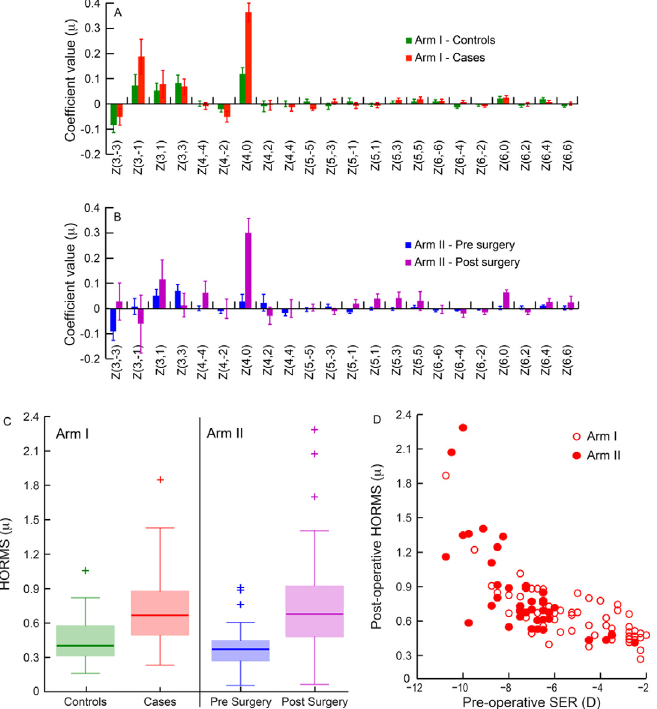
Fig 1. Panels A and B: Histograms showing the pattern of HOA ’ s observed in the first arm (panel A) and second arm (panel B) of the study. Each bar represents the median (25 th and 75 th quartiles) coefficients of each order of Zernike polynomial obtained across all subjects in the study. Even though data were obtained up to the 8 th order Zernike polynomials, only data up to the 6 th order polynomials are shown in this figure. The coefficients of 7 th and 8 th order polynomials were close to zero in all conditions. Panel C: Box and Whisker plots of the HORMS in the two arms of the study. The solid horizontal line indicates the median HORMS, the bottom and top end of the box indicates the 25th and 75 th quartiles, respectively, the error bars indicate the 1 st and 99 th quartiles, respectively, and the plus symbols show outliers. Panel D: Post-operative HORMS of the subject plotted against their respective pre-operative spherical-equivalent refraction (SER) in the two arms of the study. Negative values along abscissa indicate increasing myopia.